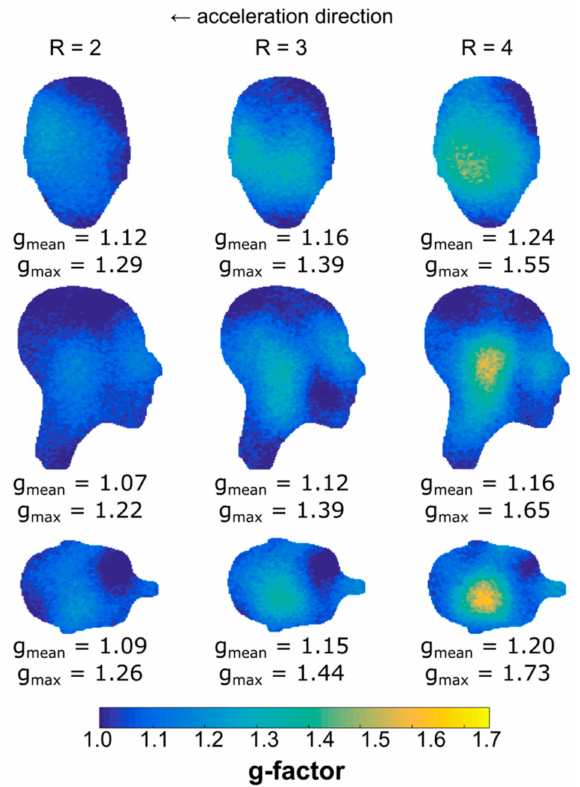
Figure 8. g-factor maps. From top to bottom: coronal, sagittal, and transversal slices through the center of the gel phantom shown in Figure 7 for acceleration factors R = 2, 3, and 4 (left to right).